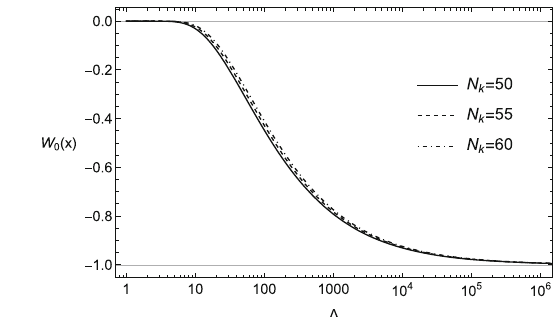
from −∞ to − 1, the horizontal black solid line, as the Δ increases from 0 to ∞ . Right: the W 0 ( x ) branch as a function of Δ and N k , which gives | cos (φ/ f ) | ≤ 1 in Eq.